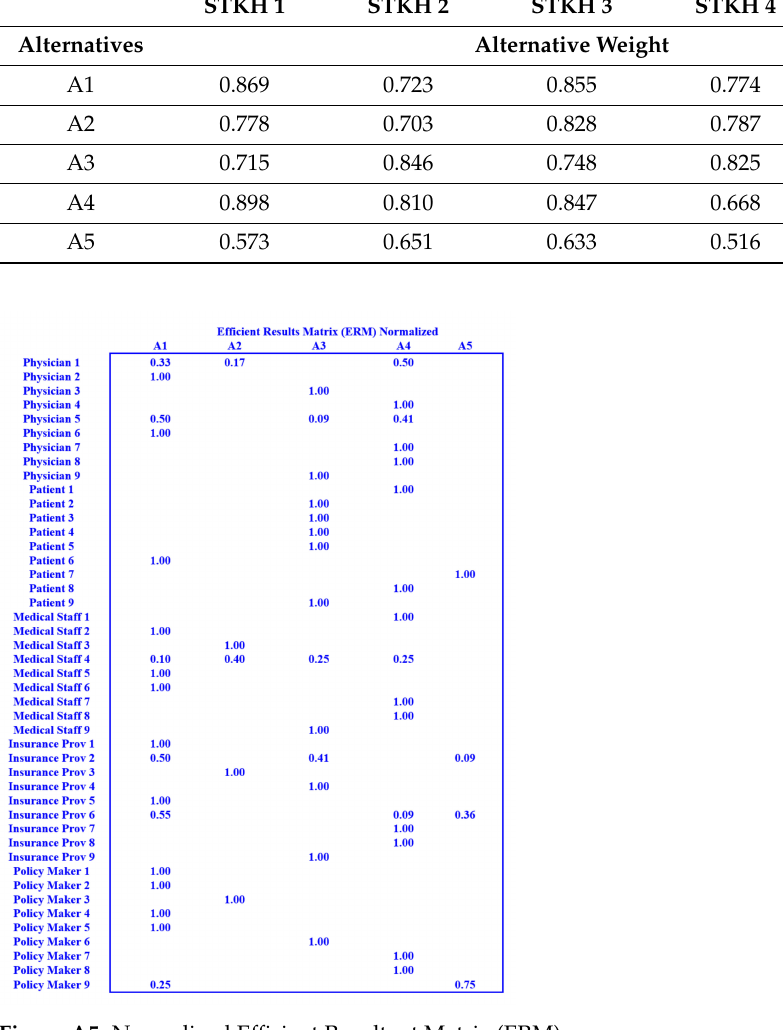
Figure A5. Normalized Efficient Resultant Matrix